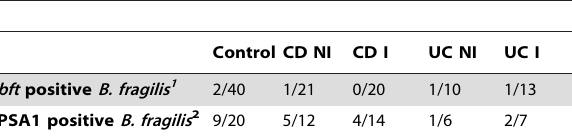
Table 4. Number of biopsies with B. fragilis where bft or PSA was present.